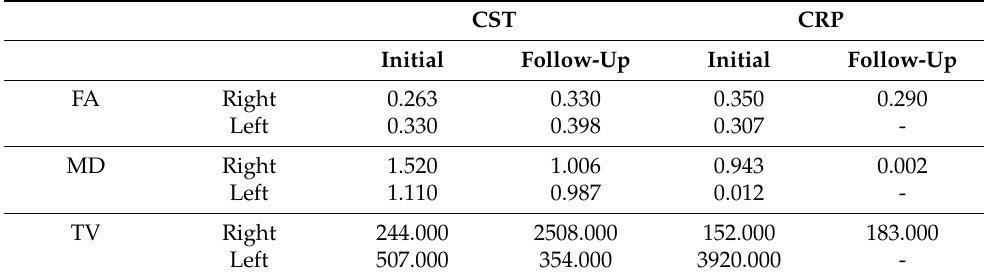
Table 1. Changes in CST and CRP pre- and